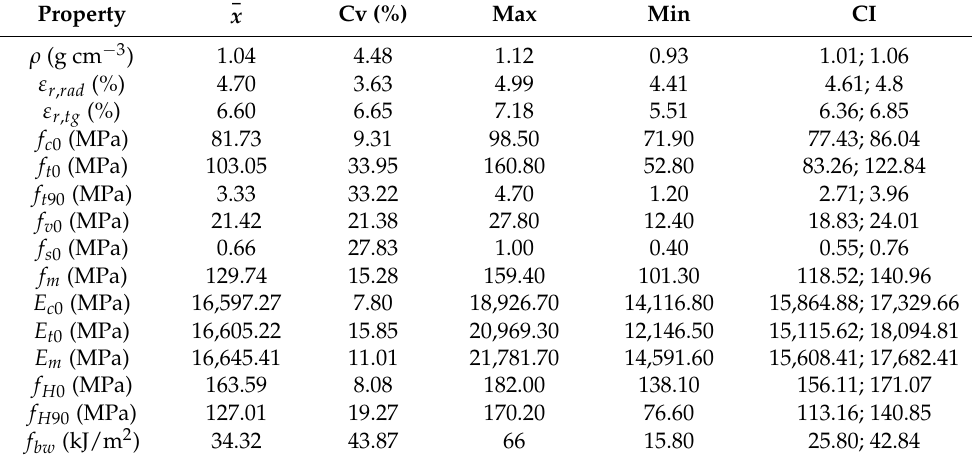
Table 1. Results of physical and mechanical properties tests for Tabebuia sp. wood from harvesting regions RR-A.